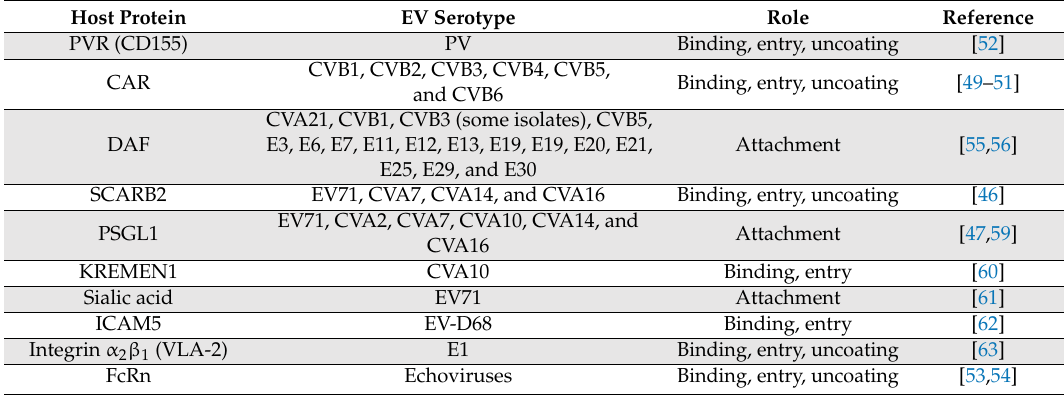
Table 1. Enterovirus receptors and attachment